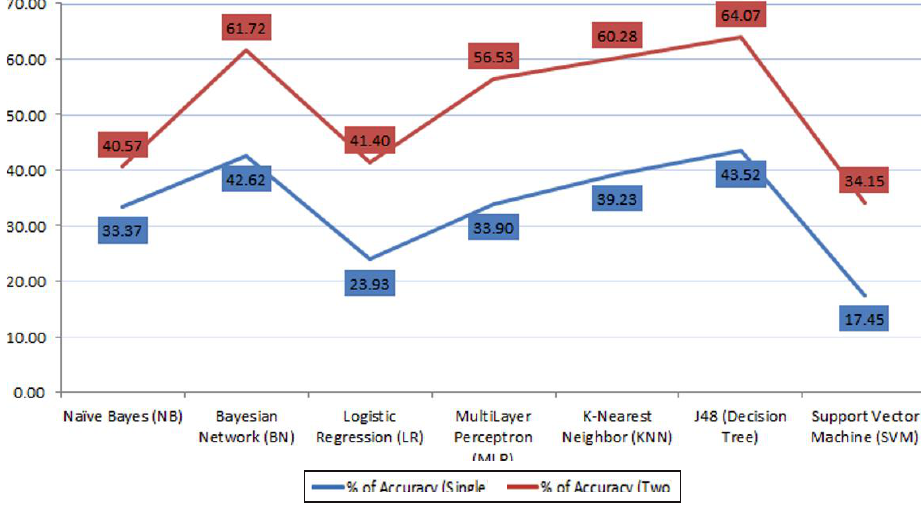
FIG. 11. RECOGNITION ACCURACY COMPARISON, 1 VS. 2, 3 AND 4 GROUPS OF TABLE 6. CLASSIFICATION MODELS, 1 VS. 2, 3 AND 4 GROUPS (TIME TAKEN TO BUILD MODEL)